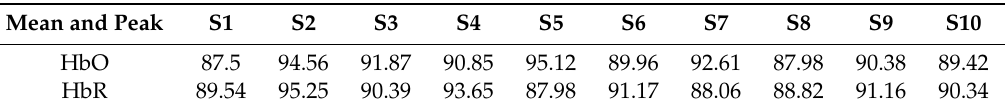
Table 2. The classification accuracies of the mean-peak feature combinations obtained from HbR signals.